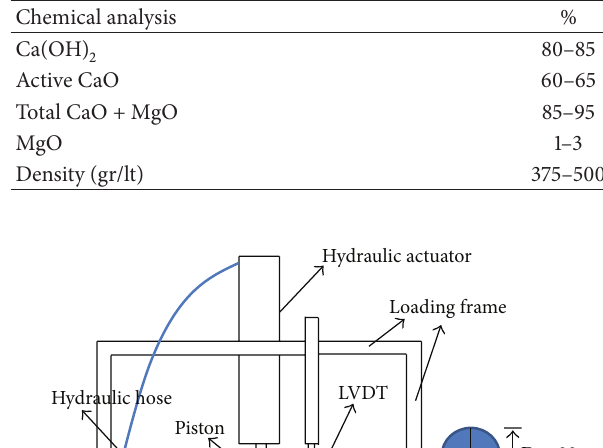
Table 5: Chemical analysis of the lime (%).